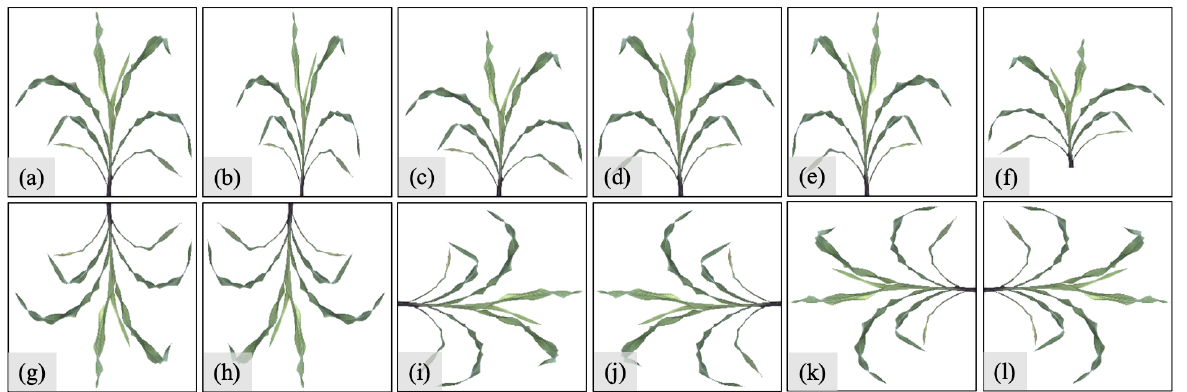
Figure 4. Image augmentation methods applied on ( a ) resized original image generated from image preprocessing: ( b ) compressed vertically; ( c ) compressed horizontally; ( d ) flipped vertically; ( e ) flipped and compressed vertically; ( f ) flipped vertically and compressed horizontally; ( g ) flipped horizontally; ( h ) rotated by 180 degrees; ( i ) rotated clockwise by 90 degrees; ( j ) rotated clockwise by 90 degrees and flipped vertically; ( k ) rotated counterclockwise by 90 degrees; and ( l ) rotated counterclockwise by 90 degrees, and then flipped